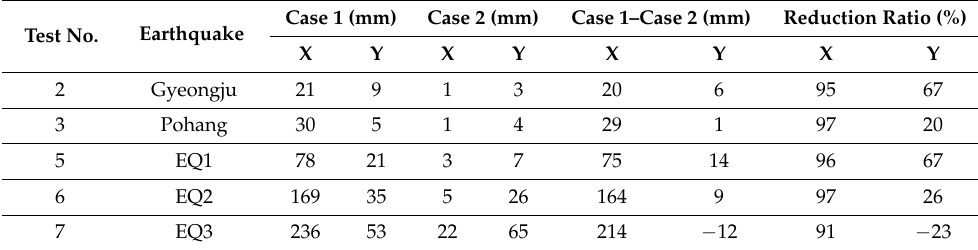
Figure 10. Response of strain and relative displacement of the RTU: ( a ) strain response and ( b ) di— placement response. Table 10. Relative displacements under seismic simulation